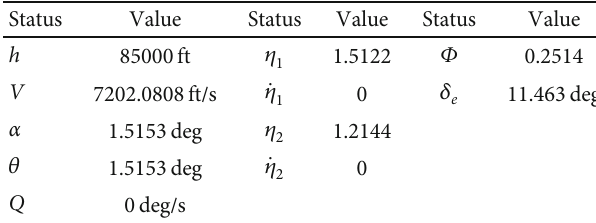
Table 3: Trim condition of the hypersonic